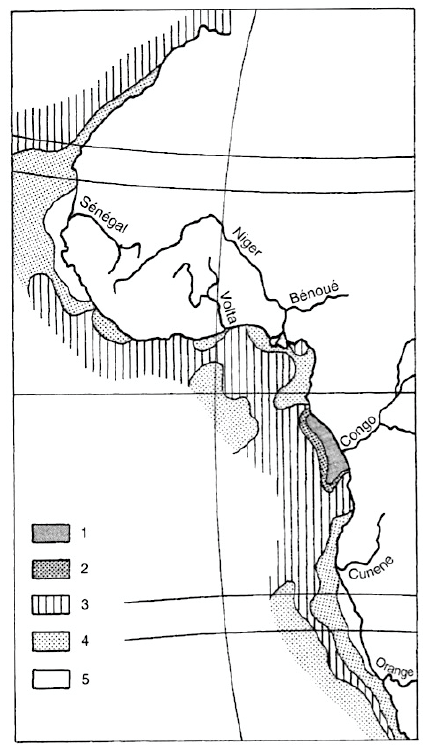
Figure 1. Iron deposition in the upper 0.5 cm of the sediments of the Atlantic margin of Africa. Iron contents (Fe 2 O 3 wt.%) were measured on the terrigenous fraction (without carbonate, organic carbon, or biogenic silica); 1. >10%, 2. 7%–10%, 3. 5%–7%, 4. 3%–5%, 5. <3%, modified after Emelyanov